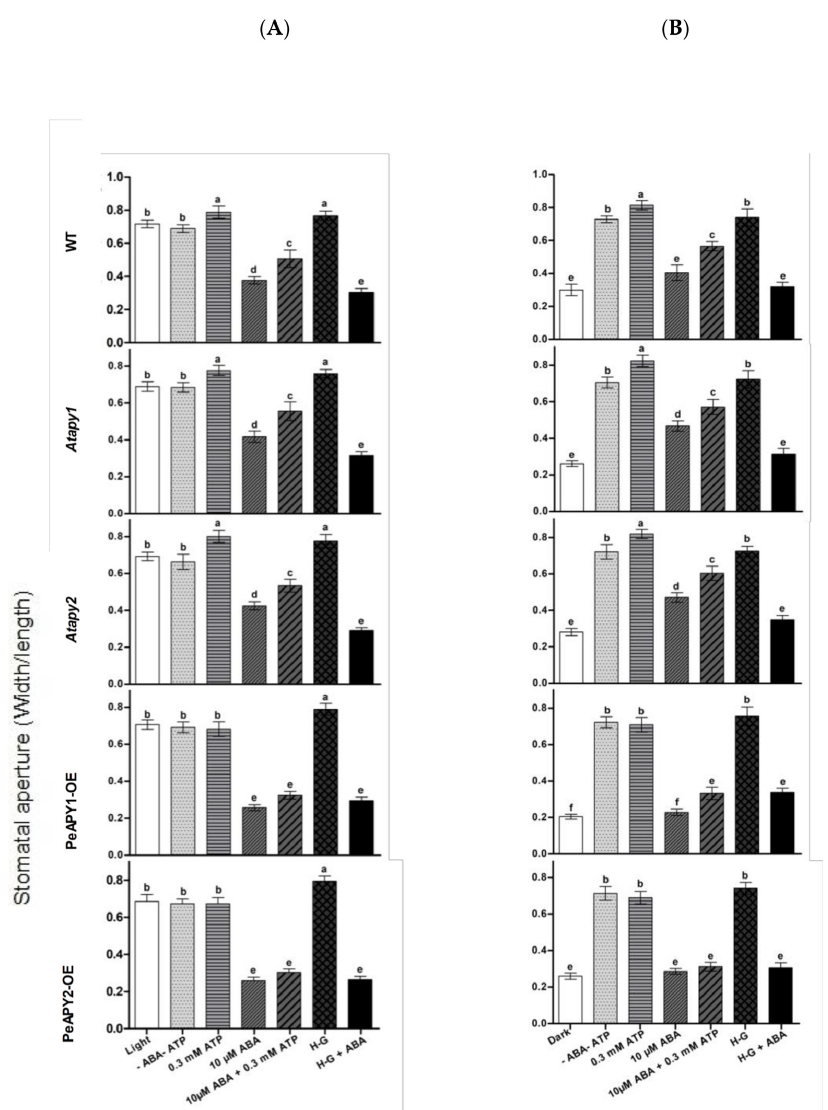
Figure 5. Effects of ATP and ATP trap on ABA-regulated stomatal aperture in wild-type (WT), Arabidopsis loss-of-function mutants for APY1 and APY2 ( Atapy1 and Atapy2 ) and transgenic lines of PeAPY1 and PeAPY2 (PeAPY1-OE and PeAPY2-OE). Leaves from three-week-old seedlings were incubated in MES-Tris buffer containing 50 mM KCl and 10 mM MES-Tris (pH 6.15) for 2 h in light (150 µ mol m − 2 s − 1 ) ( A ) or in darkness ( B ). Thereafter, leaves were exposed to 0.3 mM eATP or H-G trap that comprised 50 mM glucose and 100 U mL − 1 hexokinase for 2 h in cool light (200 µ mol m − 2 s − 1 ) in the presence and absence of ABA (10 µ M). Controls (-ATP-ABA) were treated without the addition of ATP, H-G or ABA. Stomatal aperture was measured in continuously illuminated leaves ( A ) and dark- adapted plants transferred to light ( B ), respectively. Each column is the mean of three independent experiments, and error bars represent SE. Columns labeled with different letters, a, b, c, d, e and f, showed a significant difference at p < 0.05 between treatments and genotypes under conditions of continuous light ( A ) or dark-adapted leaves transferred to light ( B